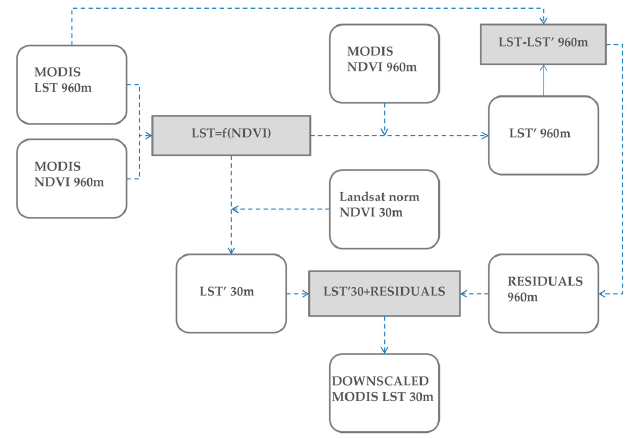
Figure 1. Disaggregation procedure for downscaling MODIS Terra land surface temperature (LST) product.